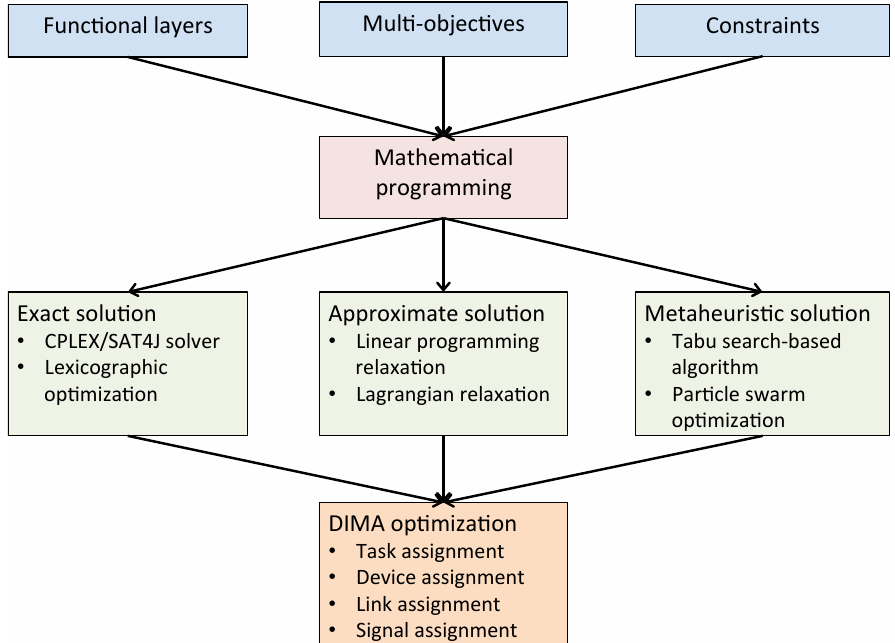
Figure 3. DIMA optimization: mathematical programming framework with incorporation of functional layers profile, system objectives and